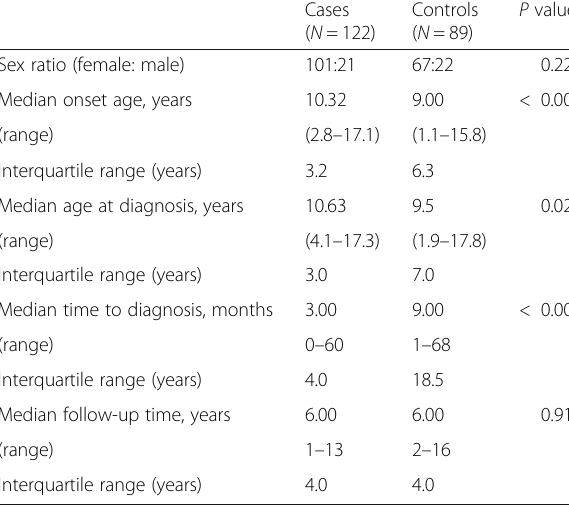
Table 1 General characteristics of case and control groups